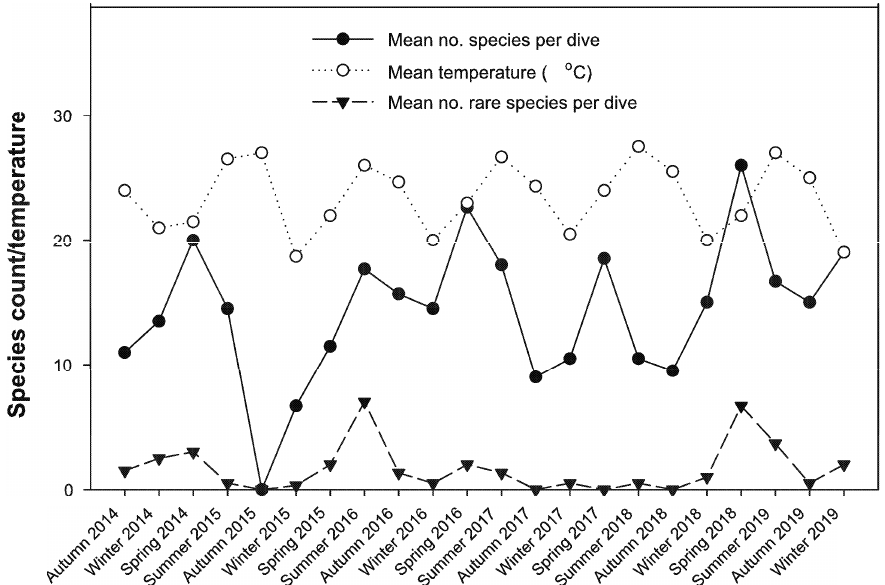
Figure 5. Trends in mean seasonal species richness per survey, mean water temperature and mean number of rare species per season—Mooloolah